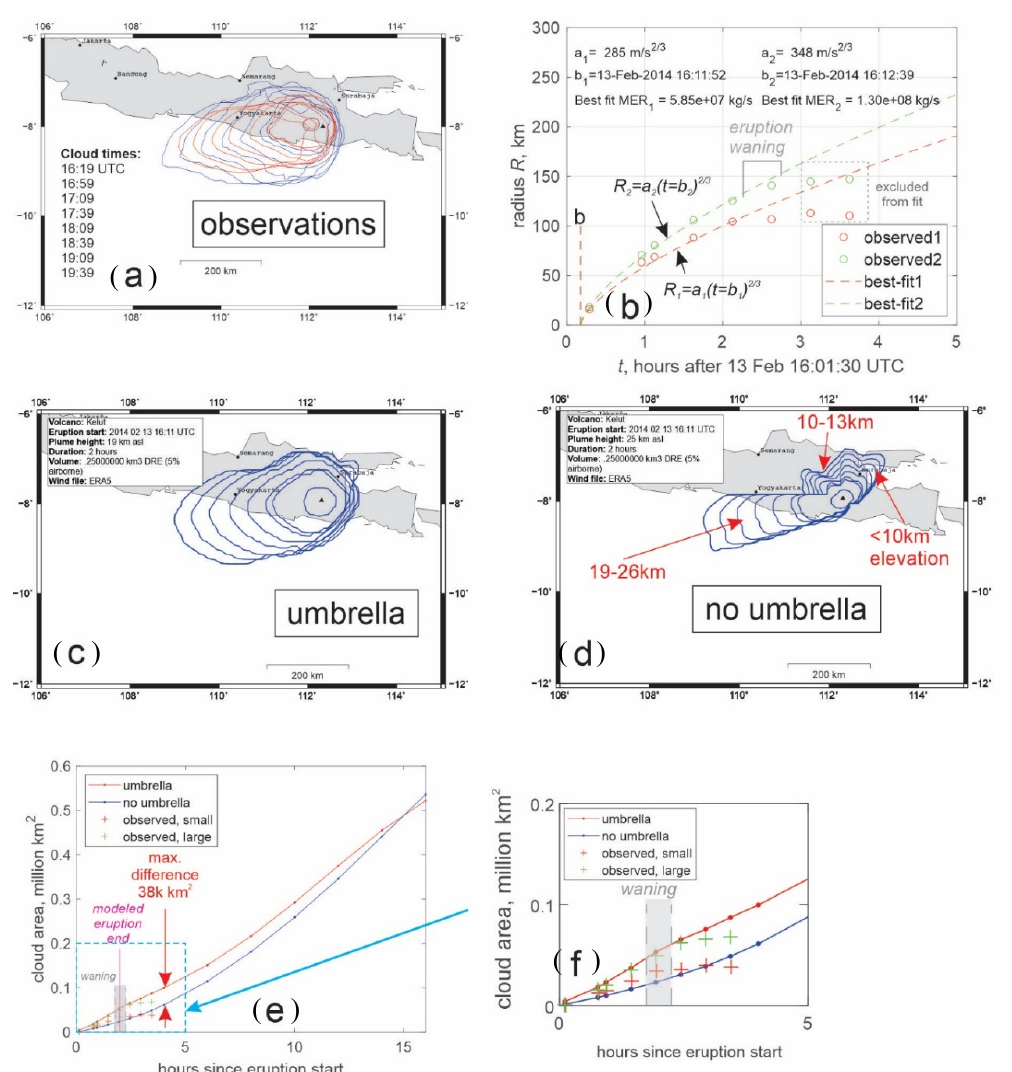
Figure 4. ( a ) Outlines of the Kelud cloud on 13 February 2014 as digitized in MTSAT-1R IR channel 13 images. The exact footprint was frequently ambiguous in these grayscale IR images, so we digitized two cloud outlines, one having a relatively smaller and the other a larger footprint. Blue lines illustrate the larger footprint, red lines the smaller. Satellite images with the hand-drawn lines superimposed are shown in Figure S6. The outlines correspond (from inner to outer) to times of 16:19, 16:59, 17:09, 17:39, 18:09, 18:39, 19:09, and 19:39 UTC. Due to the location of the satellite, 140° E longitude on the equatorial plane, parallax displaced clouds at 20 km altitude about 9 km WNW in map view. Effects of image distortion and parallax on these outlines have not been analyzed. ( b ) Radius of the Kelud cloud versus time in hours after 13 February 16:01:30 UTC. Cloud radius ( R ) is calculated as (cid:1844) = A / π , where A is cloud area. Green and red dashed lines are best-fit curves of form R = a( t − b) 2/3 through the green and red dots, respectively, where a and b are fitting coefficients having the values shown in the figure. ( c ) Ash3d simulation of the cloud, using inputs from Table 2 and calculating umbrella growth. Blue lines are cloud outlines at the same times as in Figure 2a. The cloud margin is defined as the location where the maximum cloud mass load equals 0.2 g m − 2 . The location of Kelud is marked by the black triangle. ( d ) Ash3d simulation using the inputs in Table 2, without an umbrella cloud. ( e ) Cloud area versus hours after the eruption start. Crosses are observations from Figure 4b; the red line is the model forecast including umbrella growth, and the blue line is the model forecast not including umbrella growth. ( f ) Close-up of the first five hours of cloud growth shown in Figure